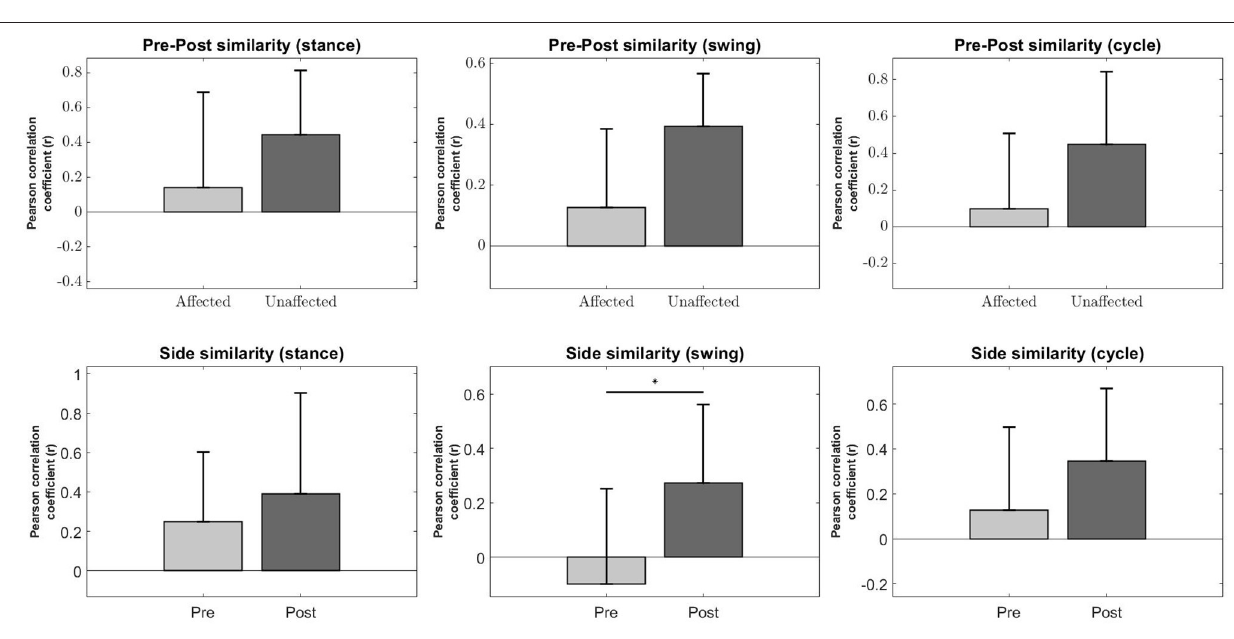
FIGURE 8 | Synergy comparison between conditions. Error bars denote standard deviation. Pre-Post comparison of r between affected and unaffected side during Stance, Swing and Full gait cycle (Top Row) . Side comparison of r before and after robotic intervention during Stance, Swing and Fully gait cycle (Bottom Row) . The asterisks indicate statistical